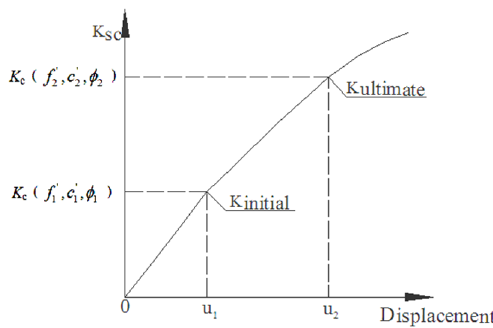
Figure 3. Typical relationship curve of slope displacement vs. K sc .